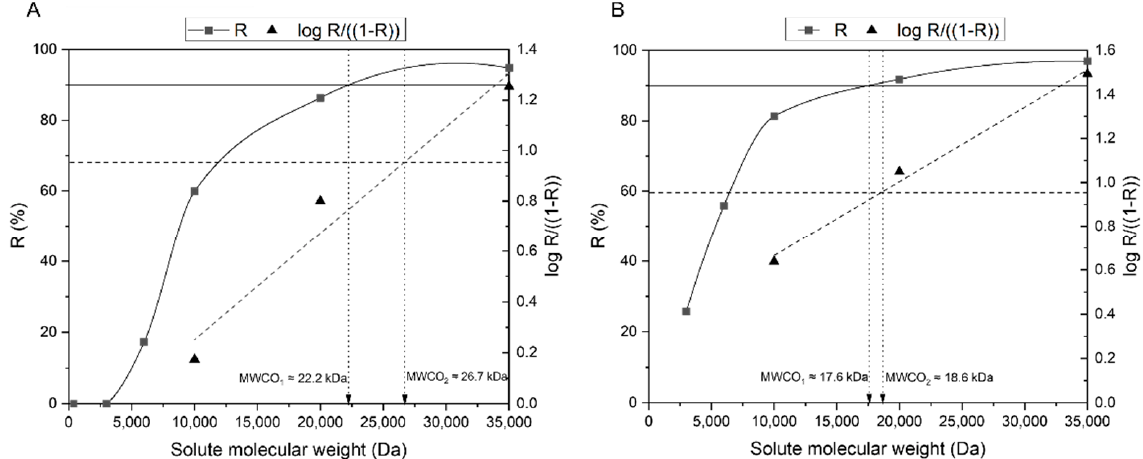
Figure 8. Rejection coefficient profiles of the CA-SiO 2 -(CH 2 ) 3 NH 2 ( A ) and CA ( B ) membranes to solutes with increasing molecular weights: 400, 3000, 6000, 10,000, 20,000, and 35,000 Da. The horizontal full lines are set for a rejection of 90%, i.e., log 1 − R R = 0.95. The dashed rejection lines represent the linearization of the rejection coefficients obtained for 3 different molecular weight solutes: 10,000, 20,000, and 35,000 Da. The dotted dropdown lines indicate the estimated MWCO according to the method employed.